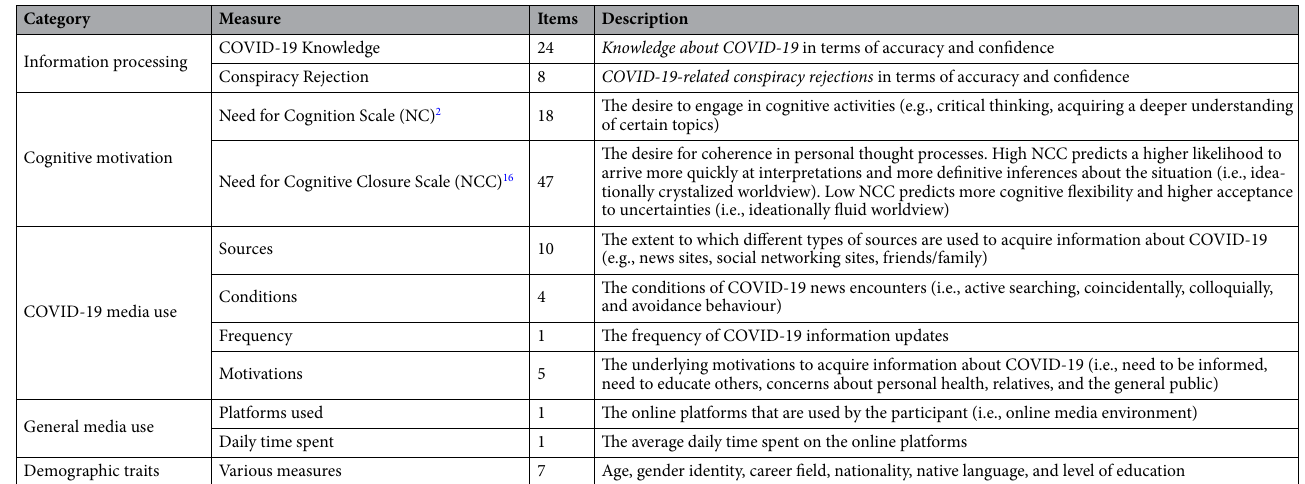
Table 2. Overview and descriptions of the measures in wave